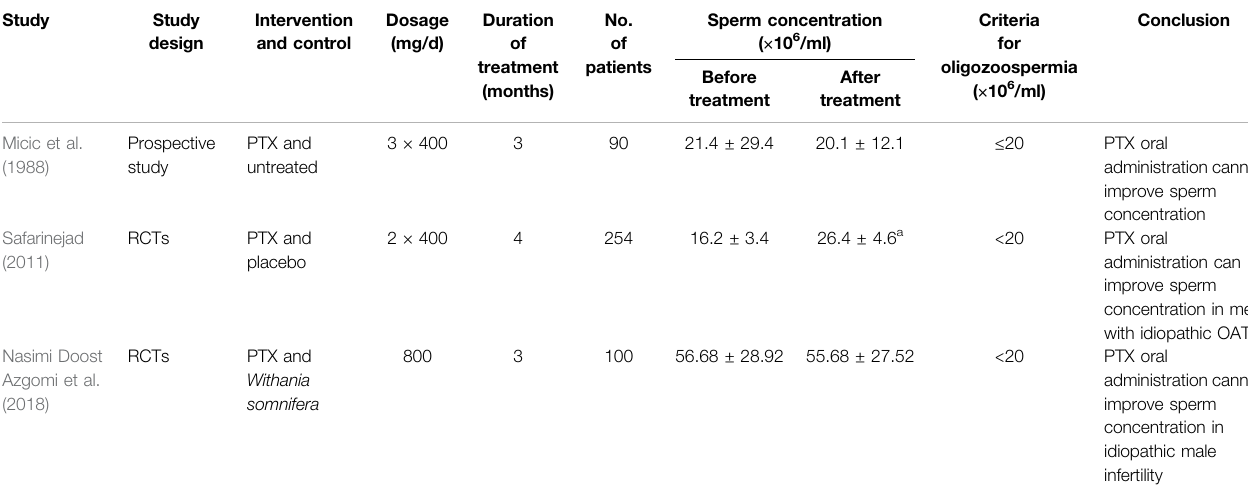
TABLE 1 | The effect of oral PTX on sperm